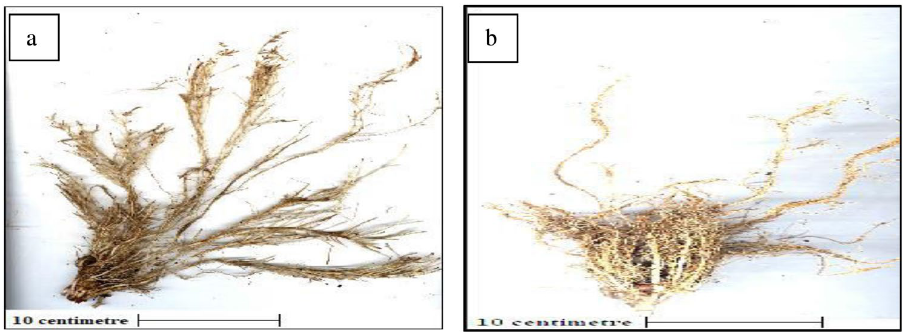
Figure 1. Root scanner images of maize inbred line LM22 under ( a ) control and ( b ) water deficit